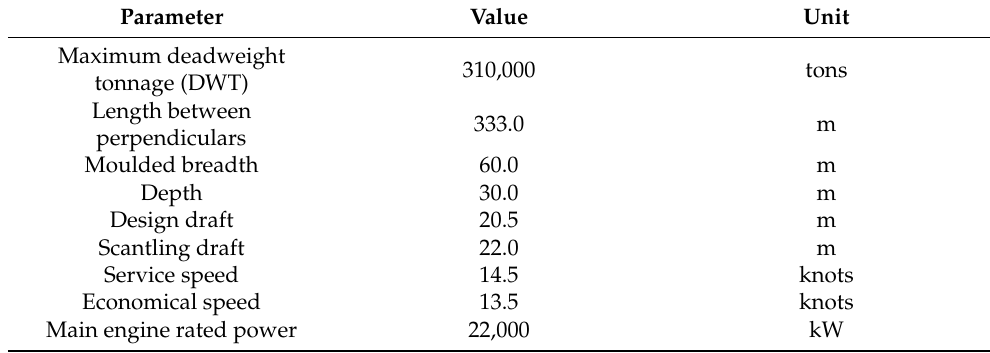
Table 1. Parameters of the